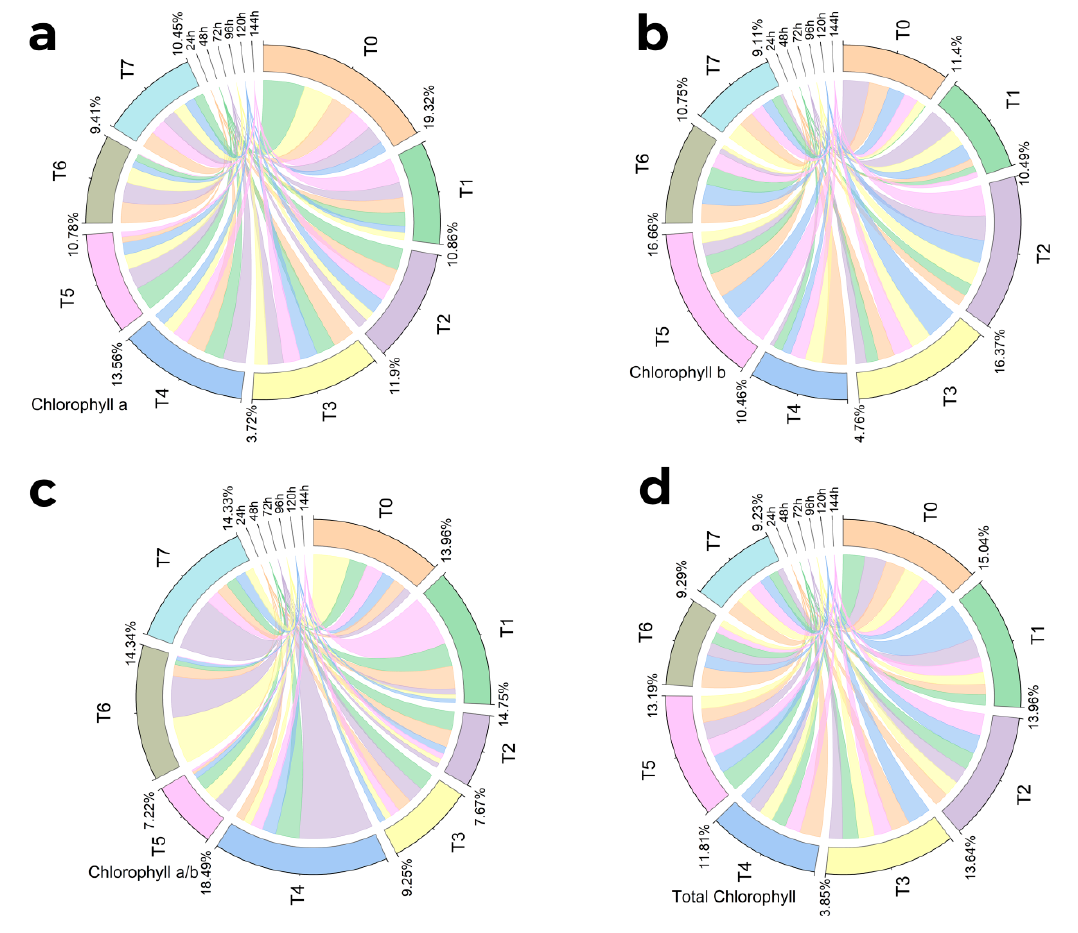
Figure 2. Chord diagram showing effect of different treatments of elicitors on chlorophyll a ( a ), b ( b ), and ab ( c ) and total chlorophyll ( d ) contents of Silybum marianum in hydroponics where harvest time on x-axis, first = one day (24 h), second = 48 h, third = 72 h, fourth = 96 h, fifth = 120 h, sixth = 144 h, where (T0 = control, T1 = methyl jasmonate, T2 = silver nanoparticles, T3 = fungal elicitors, T4 = methyl jasmonate + fungal elicitors, T5 = methyl jasmonate + silver nanoparticles, T6 = fungal elicitors + silver nanoparticles, T7 = methyl jasmonate + silver nanoparticles + fungal elicitors).